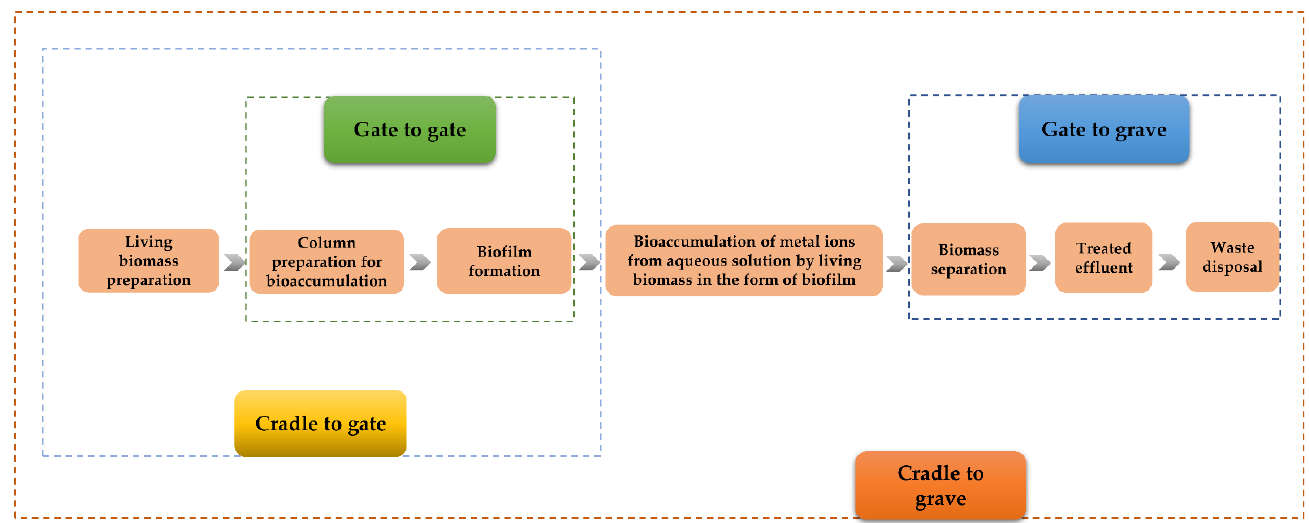
Figure 5. Life-cycle sustainability assessment framework considering the three pillars of sustainability.